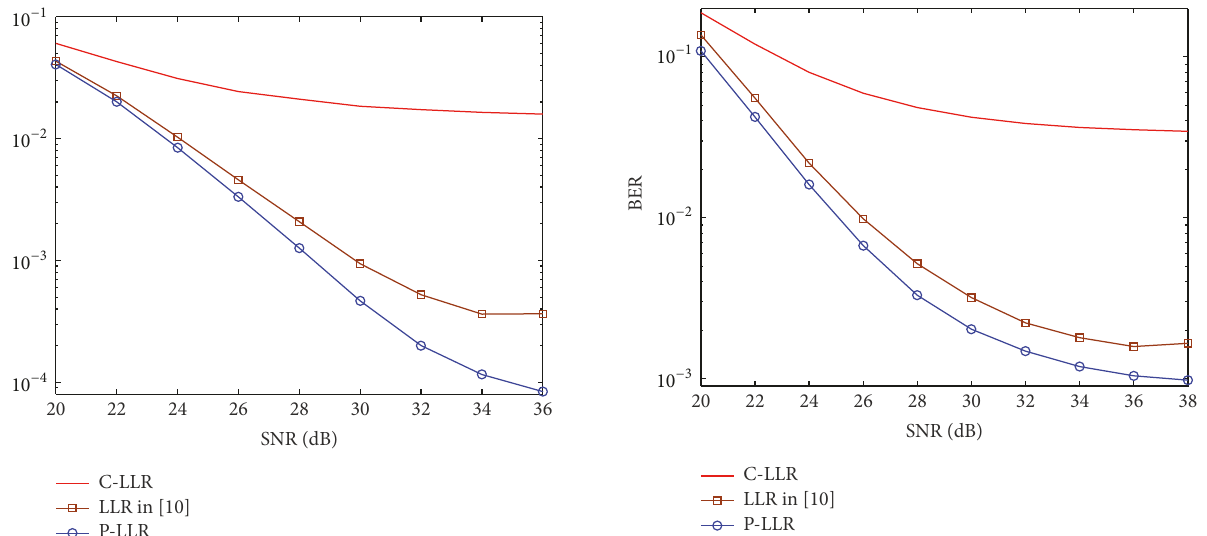
Figure 2: BER performance of various LLR algorithms for 256- QAM.